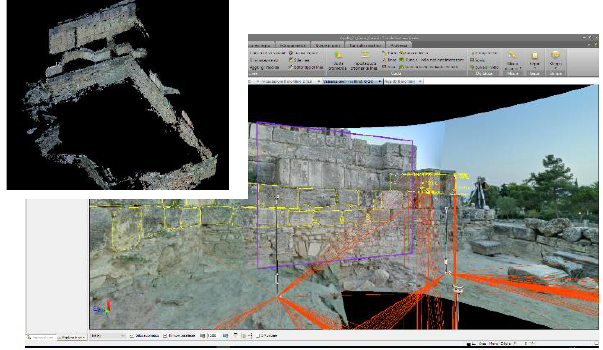
Figure 20. (above) Automatically generated point clouds using 4 IR V10 stations. (below) manual plotting using 2D and 3D